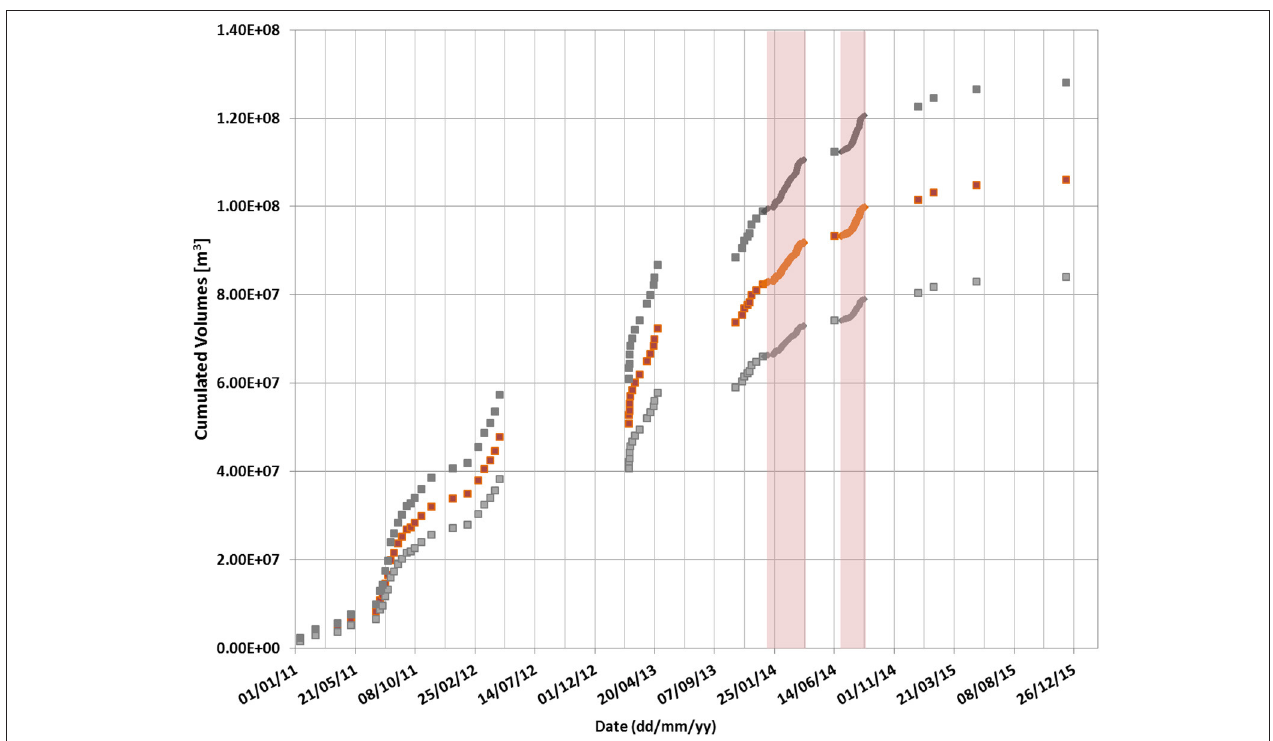
FIGURE 6 | SEVIRI-derived cumulative volume (orange square dots) with the minimum and maximum estimates (gray square dots) computed from January 2011 to December 2015. The red bars highlight the two long-lasting effusive periods of 2014.